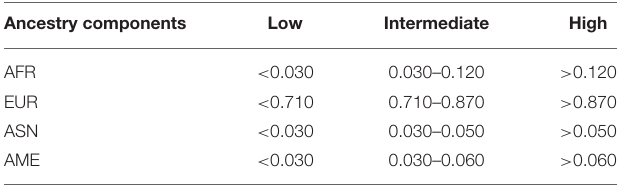
TABLE 2 | Clinicopathological features of Brazilian colorectal cancer patients ( n =